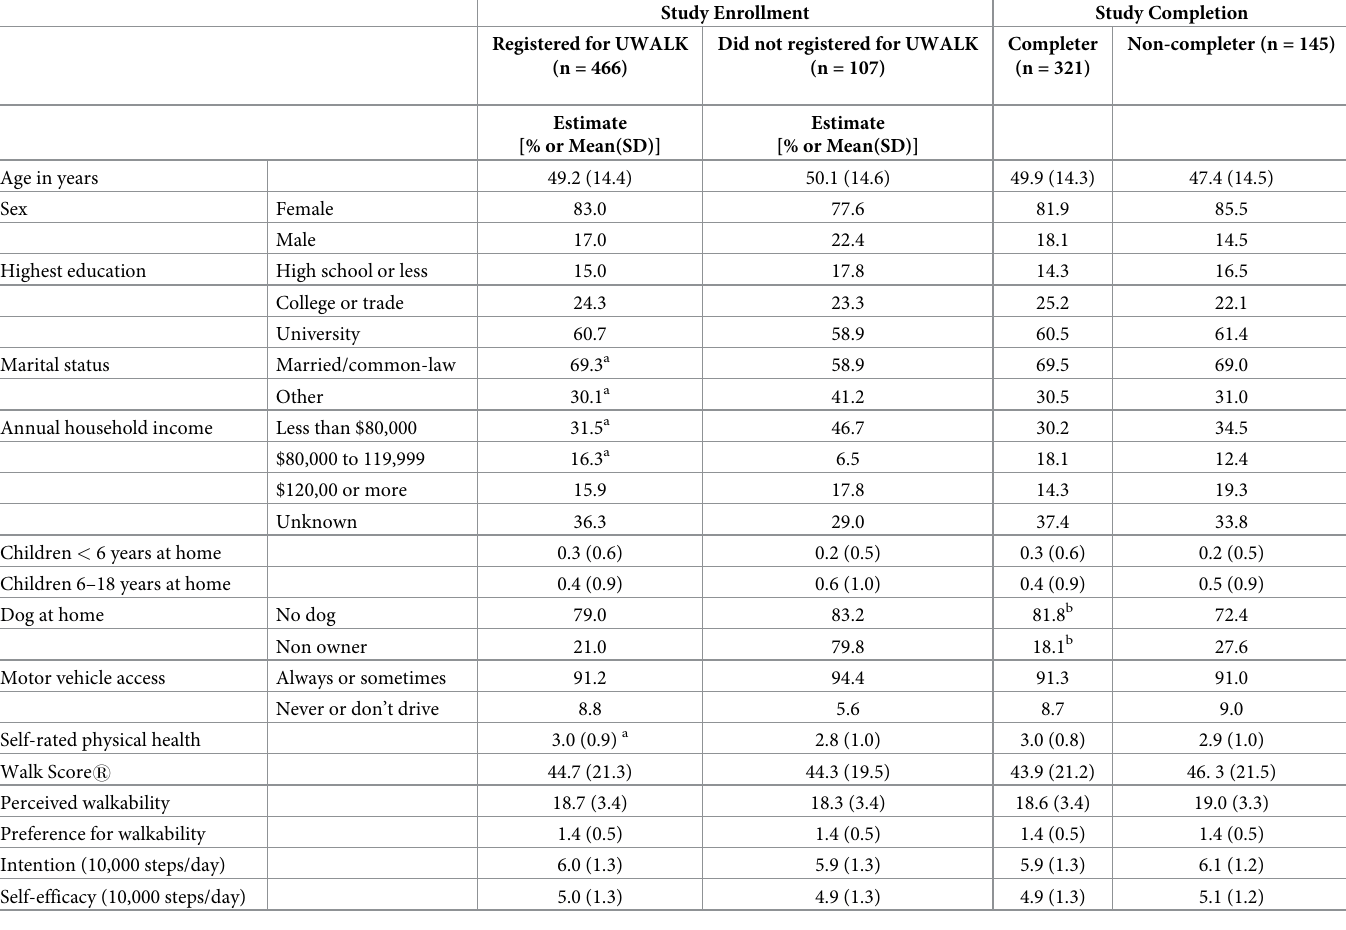
Table 1. Study enrollment, registration for UWALK, and study completion by baseline characteristics